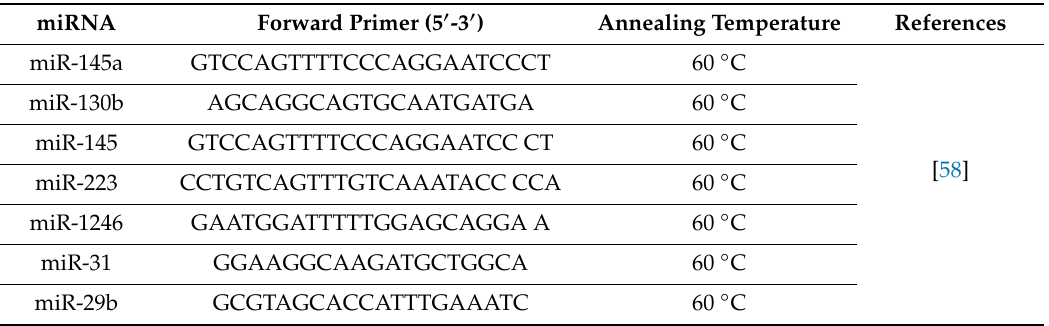
Table 4. Details of forward primer sequences used for individual miRNA analysis by